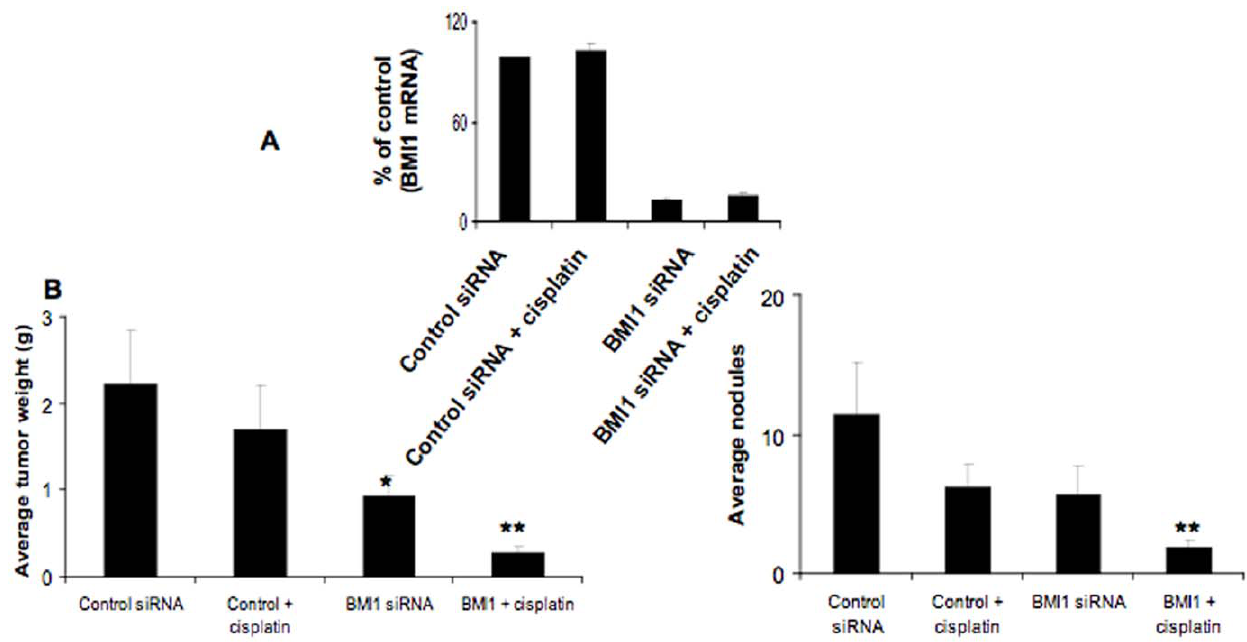
Figure 6. Effect of Bmi-1 knockdown on orthotopic chemoresistant ovarian cancer growth. To assess the effects of siRNA therapy on tumor growth, treatment was initiated 1 wk after i.p. injection (1.0 6 10 6 CP20) of tumor cells. Mice were divided into four groups (n=10 mice per group): (a) control siRNA-DOPC (150 m g/kg i.p. twice weekly), (b) control siRNA-DOPC + cisplatin (160 m g/mouse i.p. weekly), (c) Bmi-1 siRNA-DOPC (150 m g/kg i.p. twice weekly), and (d) Bmi-1 siRNA-DOPC + cisplatin (doses same as individual treatments). Treatment was continued until 4 weeks after tumor inoculation before sacrifice. (A) Total RNA was isolated from a portion of the tumor tissues and subjected to RT-PCR using primers for Bmi-1 and beta actin. The comparative C t method was used to calculate the relative abundance of mRNA compared with that of beta actin expression. The experiment was performed in triplicate and significance determined using two-sided Student’s t test, P , 0.05 was considered significant. (B) Mouse and tumor weights and (C) the number of tumor nodules for each group were compared using Student’s t test (for comparisons of two groups). A two-tailed P # 0.05 was deemed statistically significant.